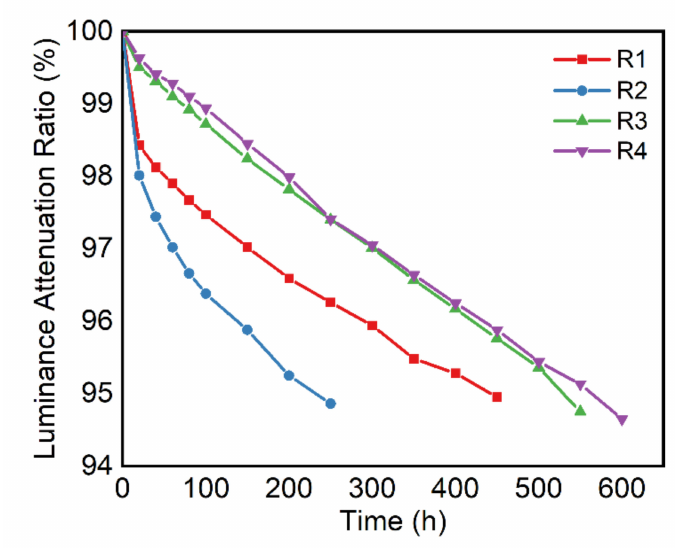
Figure 4. Operation lifetime of devices R1–R4 and T 95 at the current density of 50 mA/cm 2 .